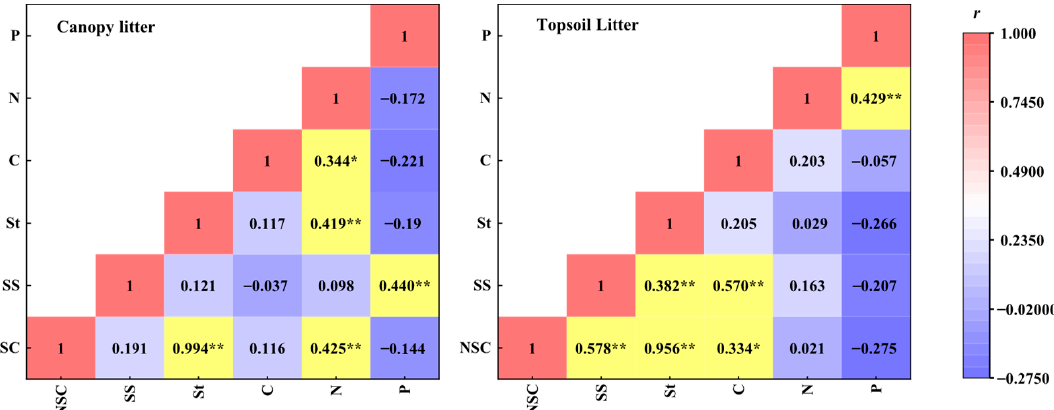
Figure 4. Correlation between non-structural carbohydrates (NSCs) and carbon (C), nitrogen (N), and phosphorus (P) contents in topsoil and canopy litter of Chinese fir. Soluble sugars (SS); starch (St). The value is correlation coefficient, asterisks denote significant correlations (** p < 0.01, * p < 0.05).